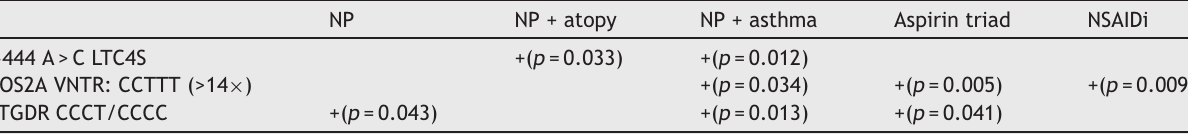
Association between LTC4S, NOS2A, and PTGDR gene polymorphisms and nasal polyps (NP), NP and atopy, NP and asthma, aspirin triad, and nonsteroidal anti-inflammatory drug intolerance (NSAIDi). NP NP + atopy